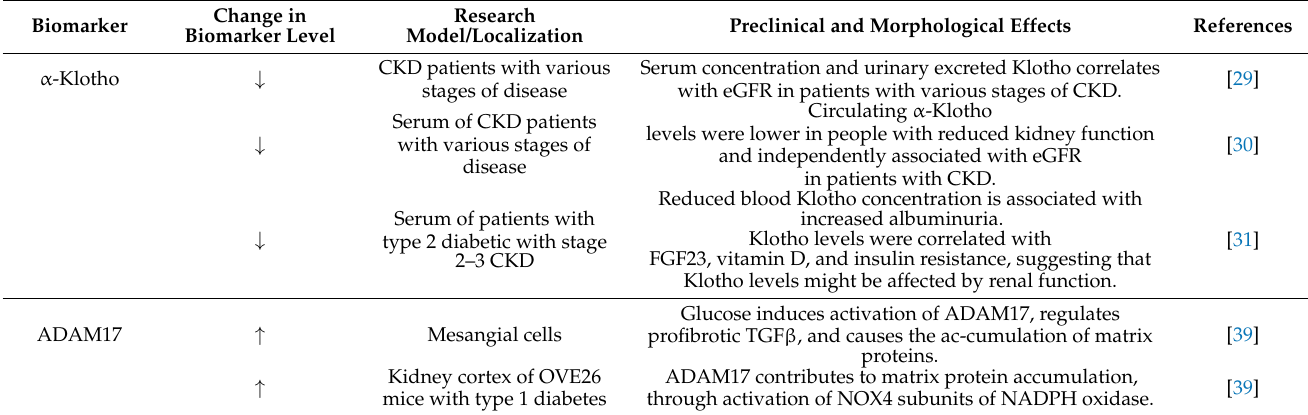
Table 1. Characteristics of potential DKD